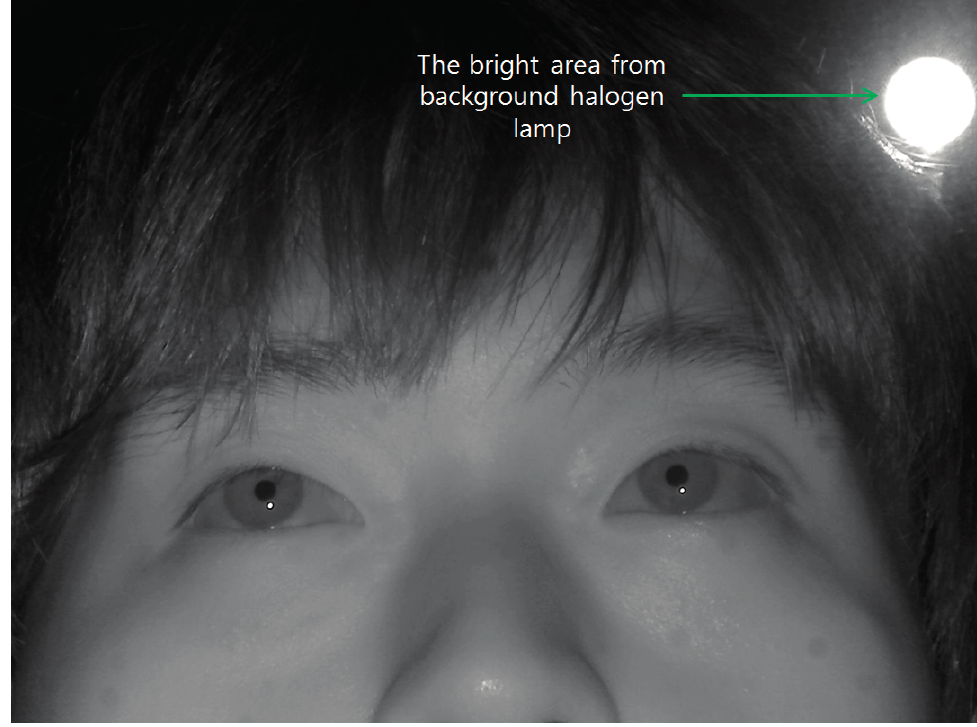
Figure 4. Captured image with halogen lamp located behind the